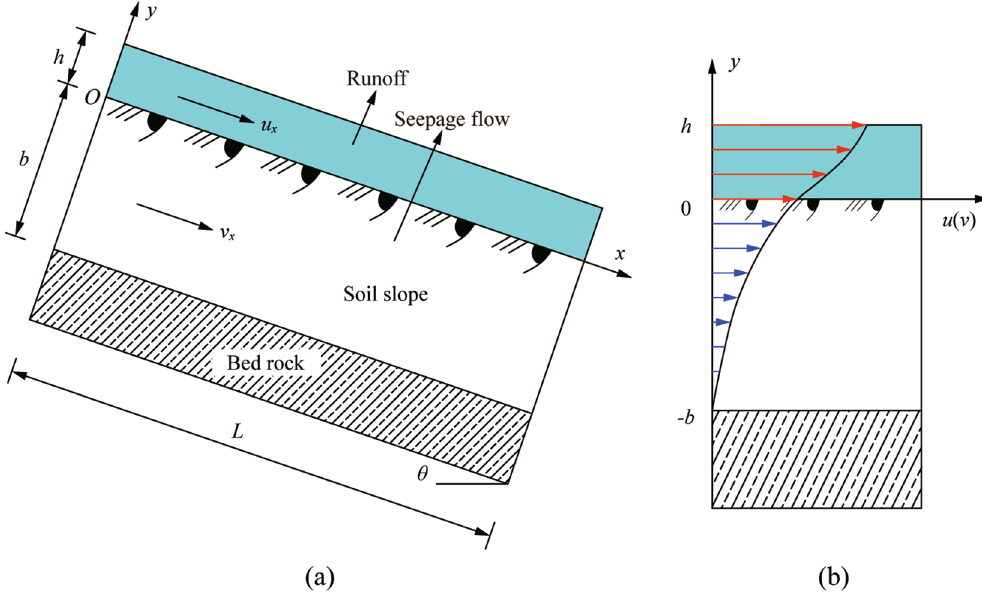
Figure 2. Coupled runoff and seepage in the soil slope model and sketch of flow velocity distribution in the y